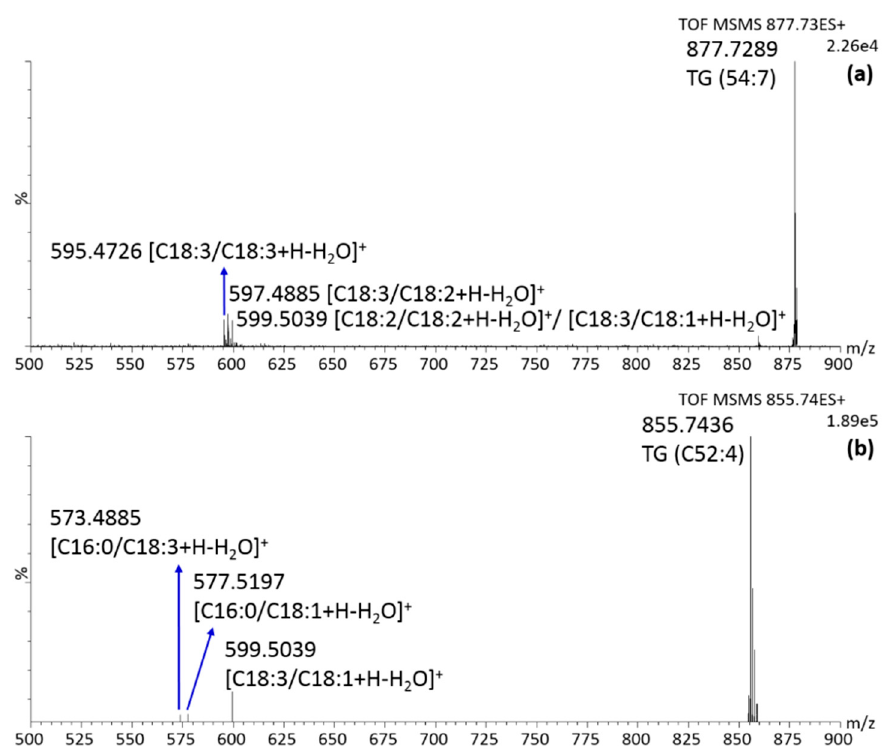
Figure 6. MS/MS spectrum in positive ionization mode over the range 500–900 m/z of ( a ) m/z 877.7289 Figure 6. MS / MS spectrum in positive ionization mode over the range 500–900 m / z of ( a ) m / z 877.7289 and; ( b ) m/z 855.7436, obtained at a collision energy of 30 eV. and; ( b ) m / z 855.7436, obtained at a collision energy of 30